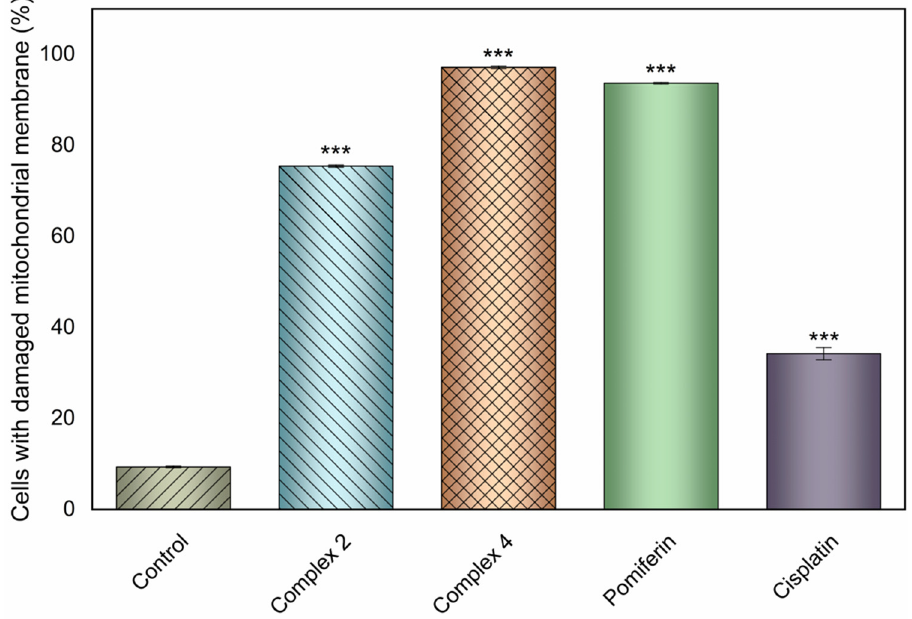
Figure 11. Mitochondrial membrane potential modifications induced by complexes 2 and 4 , pomiferin and cisplatin applied to the A2780 cells at 15 µ M after 24 h incubation. The significant change in the number of cells with damaged mitochondrial membrane caused by the respective complex as compared to the untreated control is symbolized by *** at p ≤ 0.0001 level.